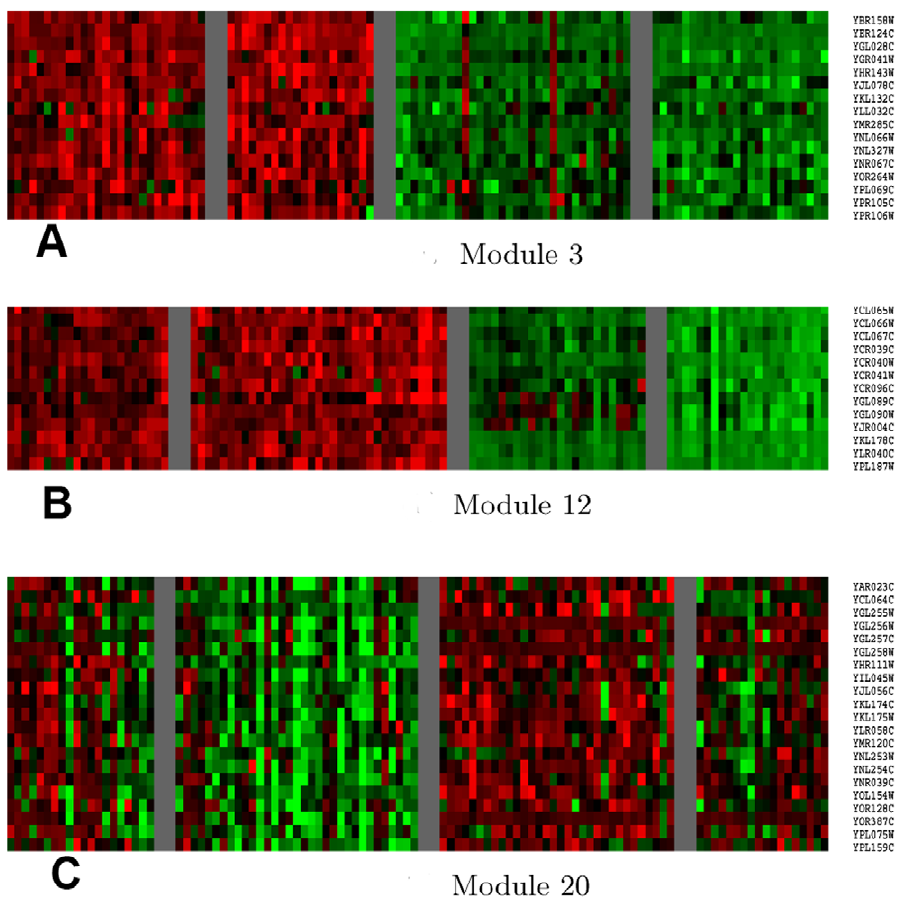
Figure 5. Heat map for expression of genes in modules. (A) for module 3; (B) for module 12; (C) for module 20. Each row represents a gene with the gene name listed on the right and each column represents an individual. Individuals are divided into four groups according to the genotypes of the two eQTLs. Over- and under-expression are indicated by red and green, respectively.